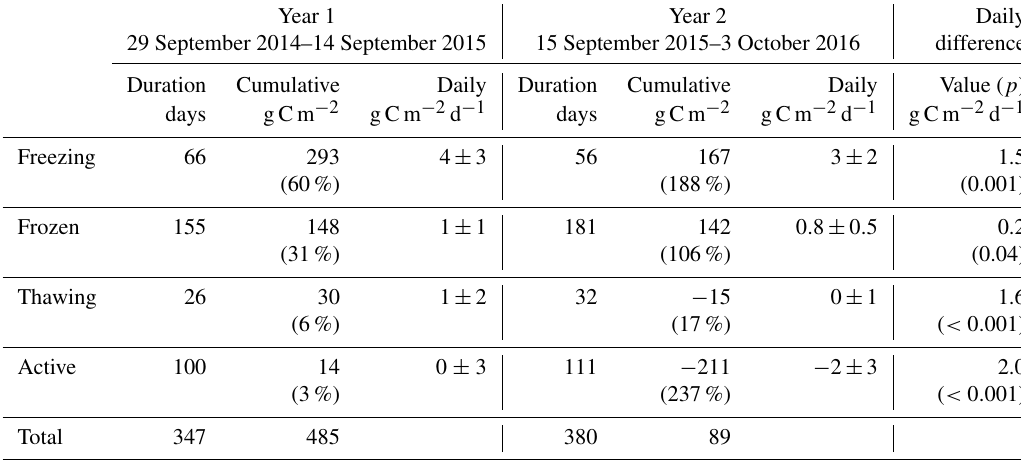
Table 2. As for Table 1 but for carbon dioxide fluxes. Seasonal percentages are represented as the absolute value of net seasonal exchange as a proportion of the annual total. As seasonal net totals are bidirectional, these percentages do not necessarily add to